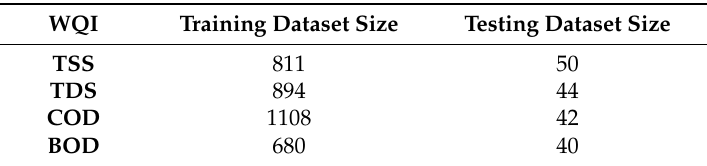
Table 1. Training and testing dataset